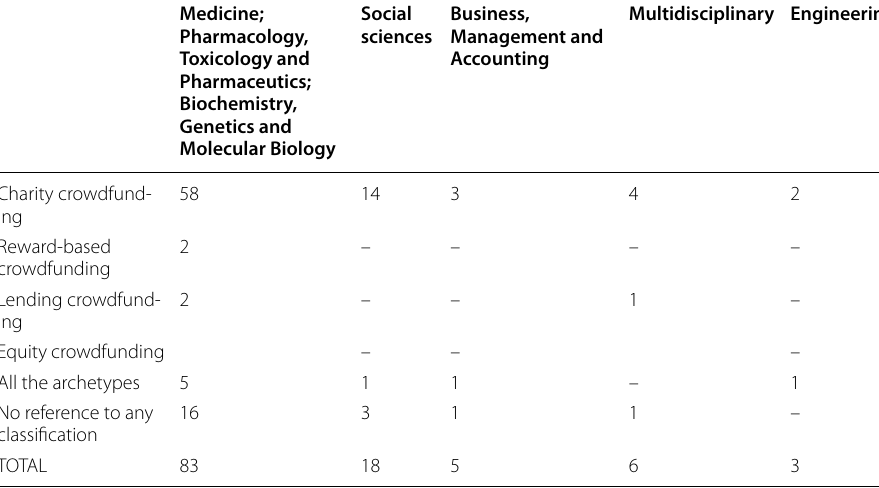
Table 2 Crowdfunding archetypes and research subject